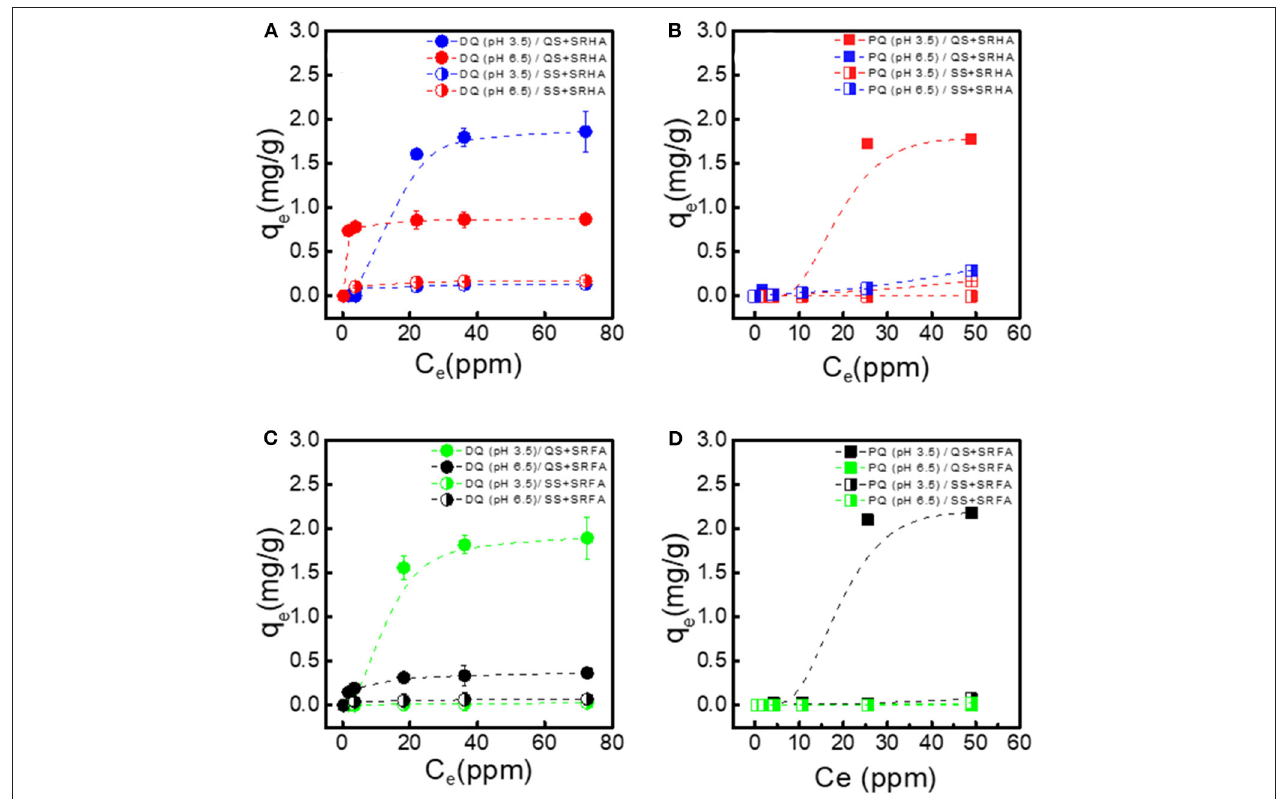
FIGURE 3 | In (A,C) Langmuir adsorption isotherms on clean quartz sand (QS) and silanized sand (SS) for DQ ( ◦ ) dissolved in KCl electrolyte adjusted at two pH conditions, pH 3.5 and pH 6.5 supplemented with Suwannee River Humic Acid (SRHA). In (B,D) adsorption isotherms on clean quartz sand (QS) and silanized sand (SS) for PQ ( 2 ) dissolved in KCl electrolyte adjusted at two pH conditions, pH 3.5 and pH 6.5 with Suwannee River Fulvic Acid (SRFA). Dashed lines are included as eye guide, and error bars represent 95% confidence intervals.